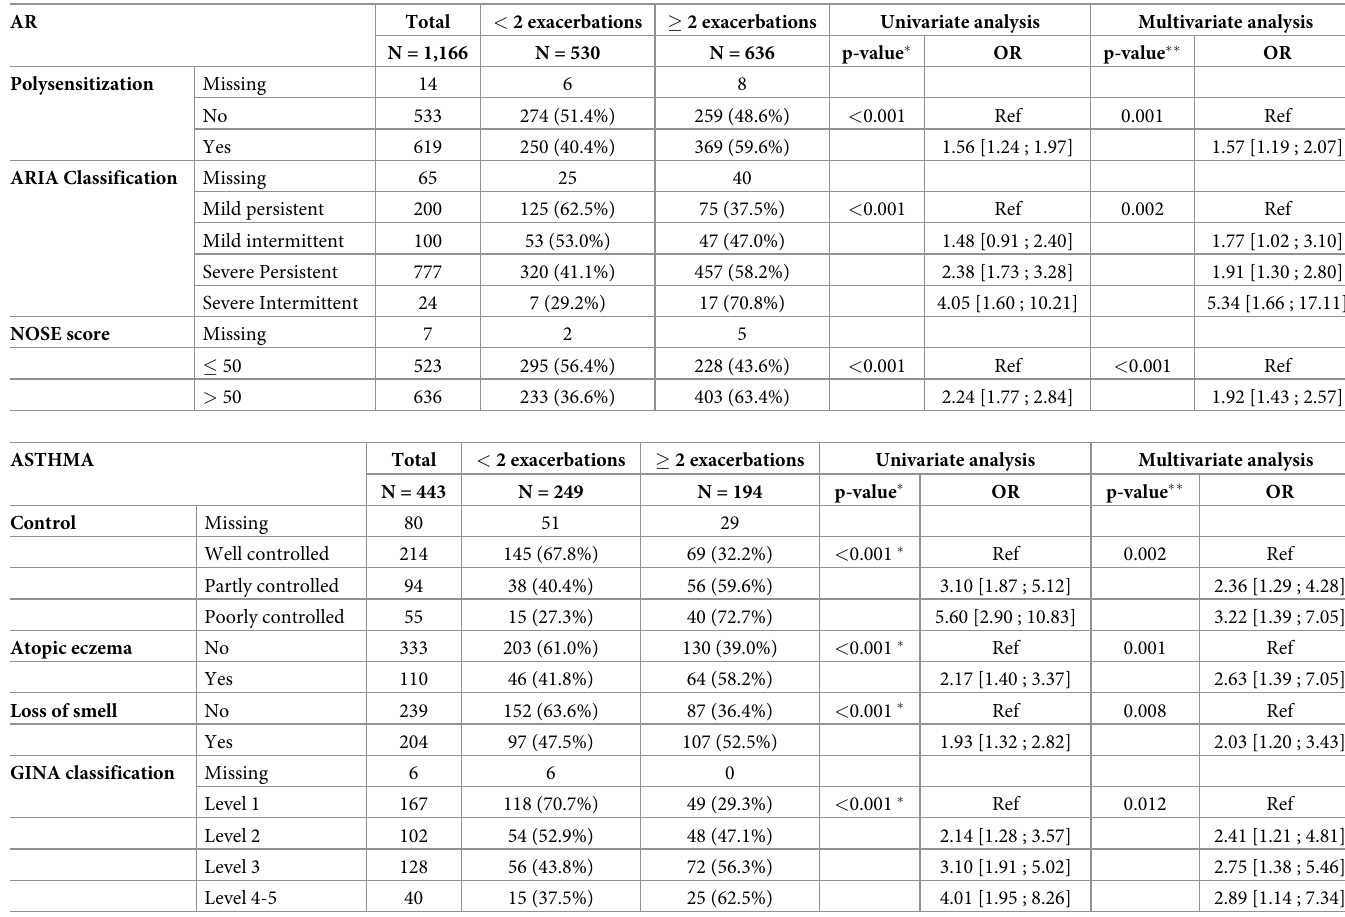
Table 4. Variables associated with the occurrence of 2 exacerbations of AR and asthma.